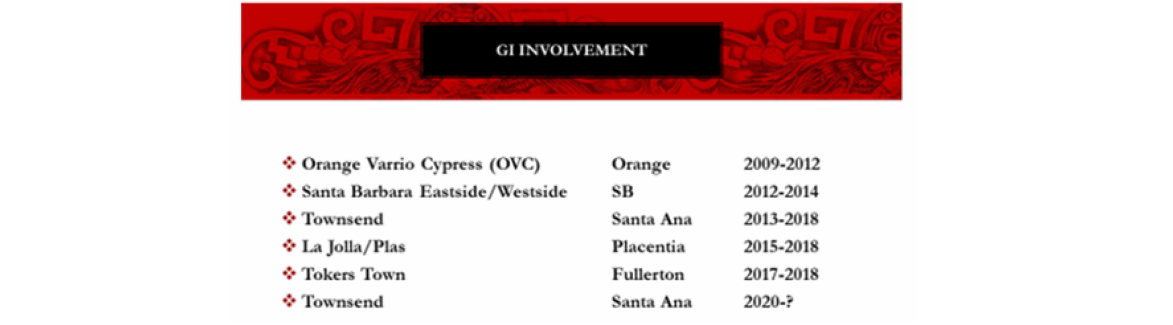
Figure 10. Slide #3 from Gabriela Hernandez’s PowerPoint for public presentations on the gang injunction